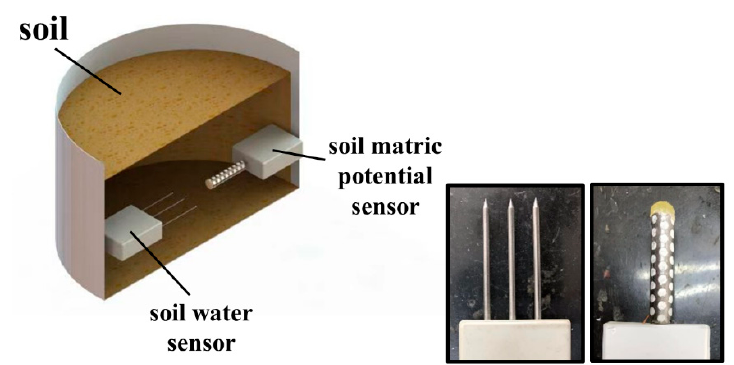
Figure 4. Diagram of the experiment.